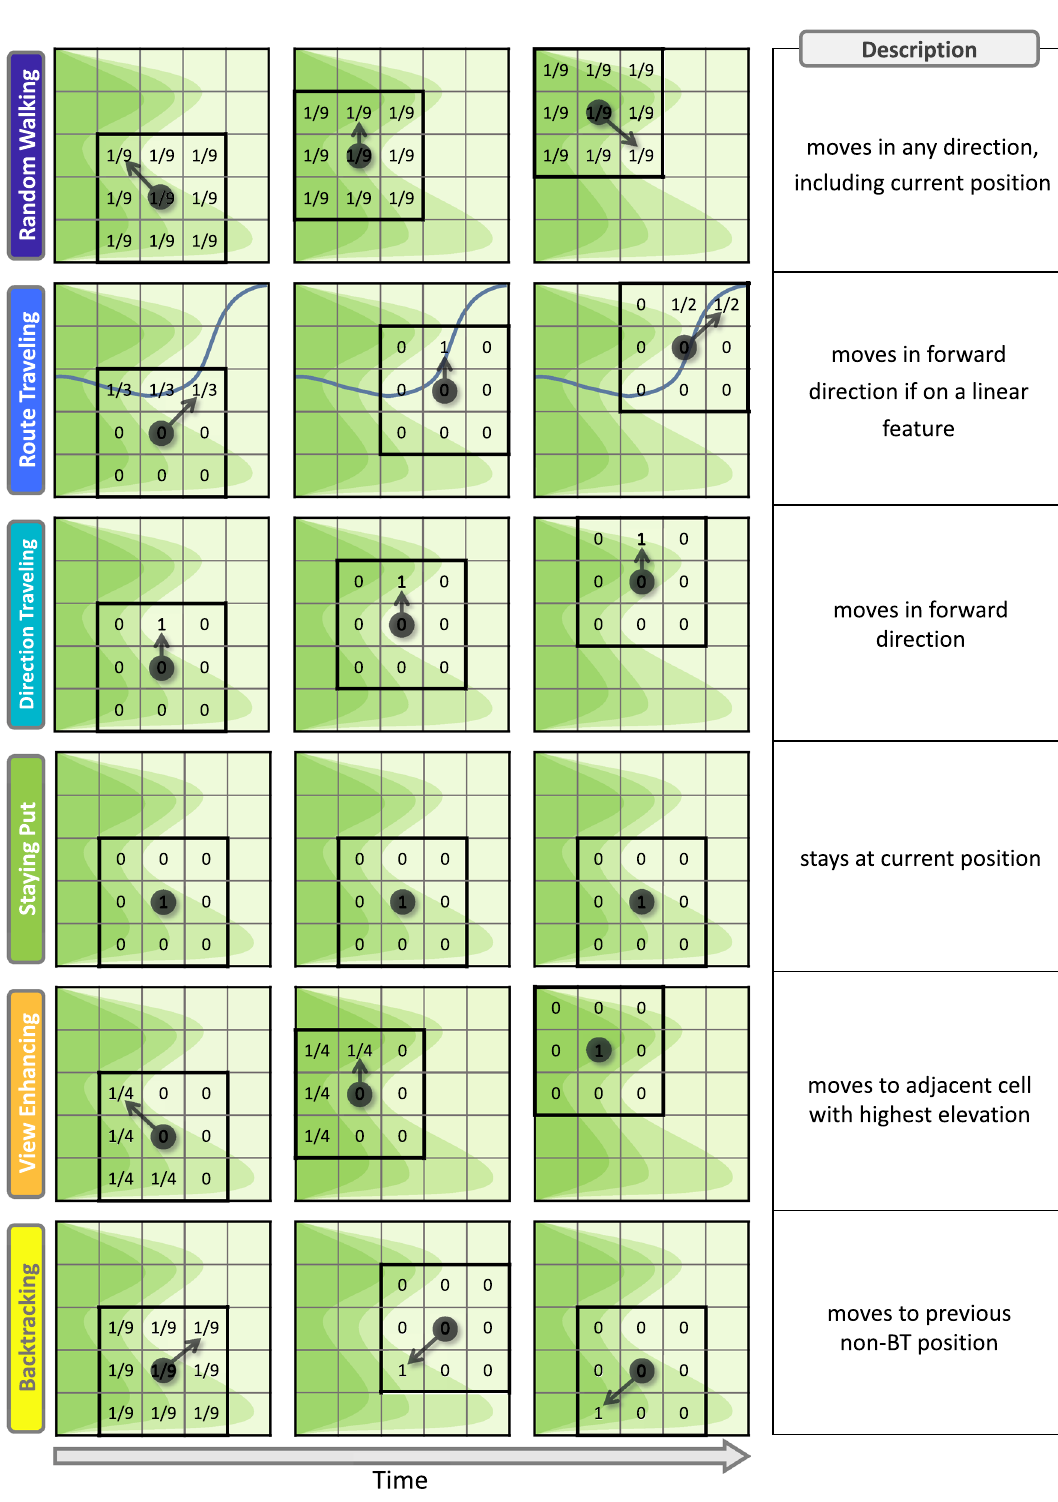
Figure 2. Schematic of an agent’s trajectories for all six behavior strategies over time. The agent’s initial positions are the circles in the left columns, located in the center of the bolded 3 × 3 grids, with the arrows denoting their next moves. The number in each box is the probability of updating to that position in the next time step using the strategy in each row, with time increasing by one step from left to right. All boxes with no number have zero probability. Linear features are represented as the blue line in the route traveling strategy, and elevation increases with a darker green